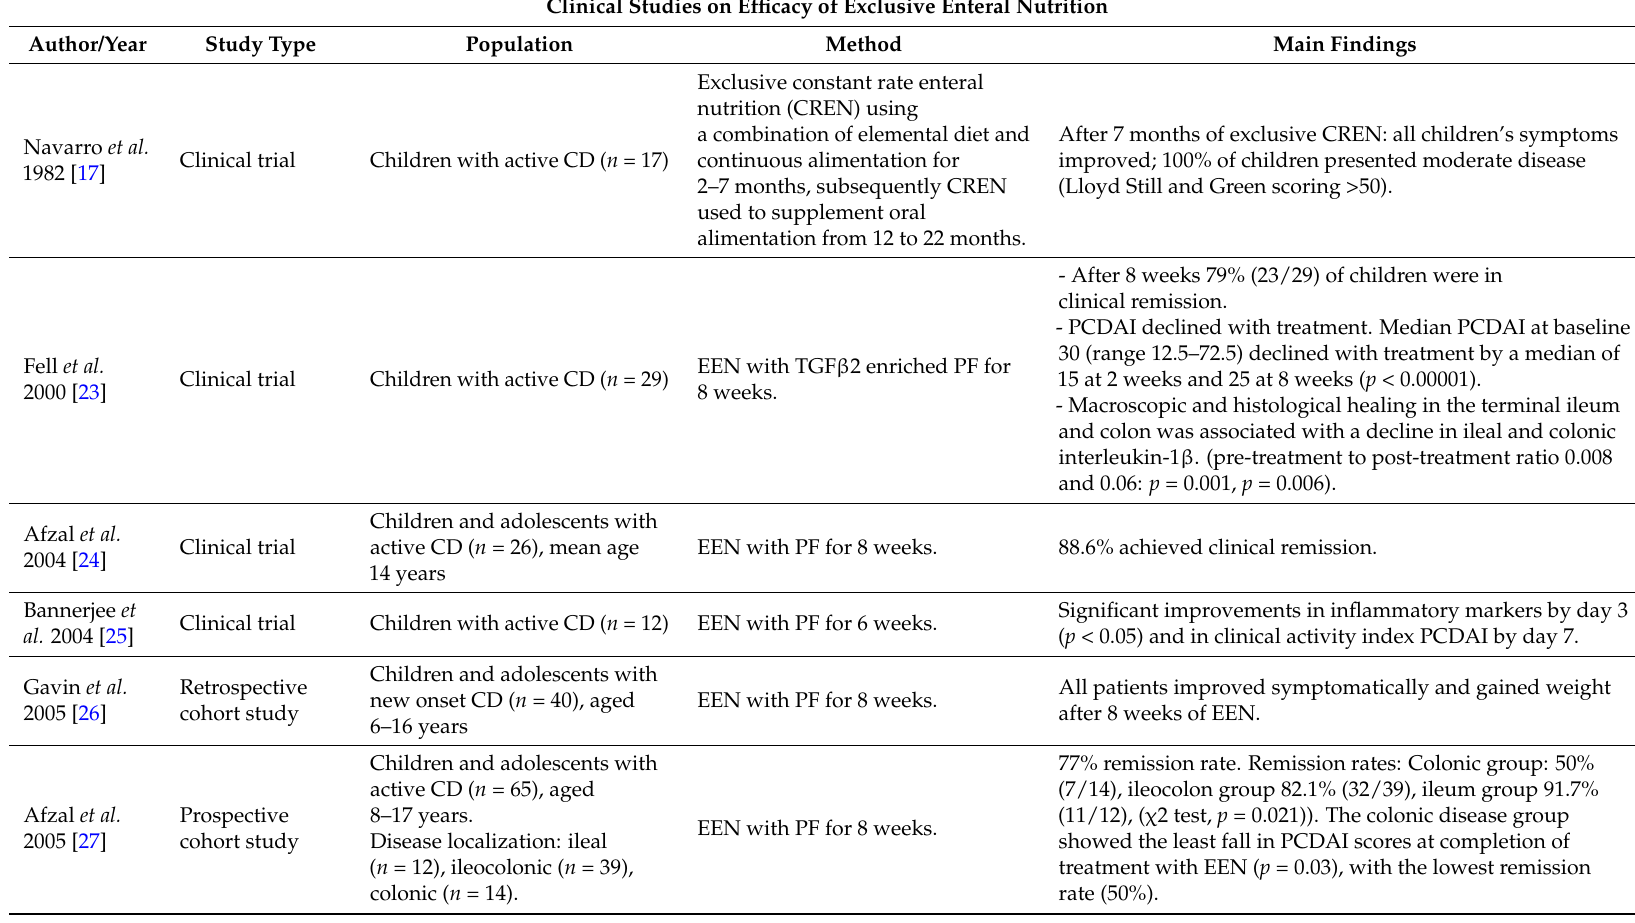
Table 2. Clinical studies on efficacy of exclusive enteral nutrition in pediatric CD. CREN = constant rate enteral nutrition, PF = polymeric formula, ED = elemental diet, PCDAI = Pediatric Crohn Disease Activity Index, PEN = partial enteral nutrition, EEN = exclusive enteral nutrition, IFX = infliximab, anti-TNF = anti-tumor necrosis factor, TGF β 2 = transforming growth factor beta